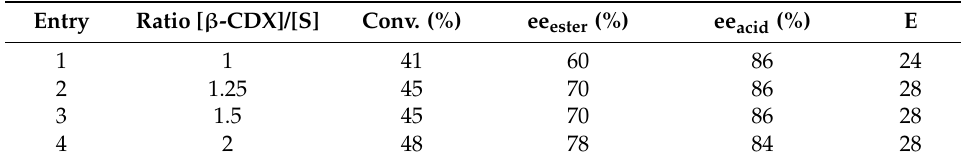
Table 5. Hydrolysis of 1e with PLE in the presence of different amounts of β -cyclodextrin ( β -CDX); conditions: [S] = 8 mM [PLE] = 5.0 mg/mL, different amounts of β -CDX in 100 mM phosphate buffer and DMSO (8%) at pH = 7.0, 25 °C. Results after 24 hours.